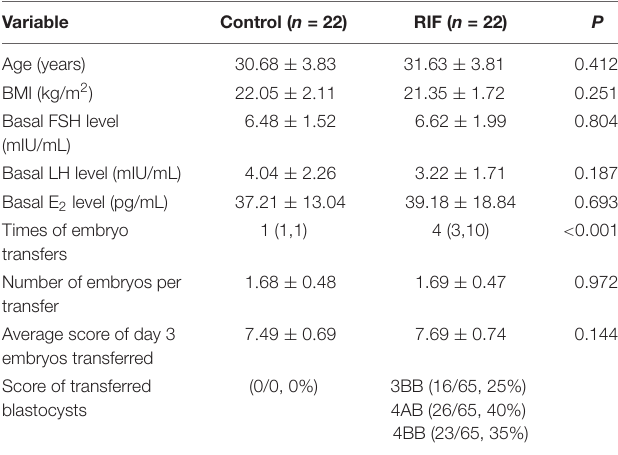
Data presented as mean ± SD or frequency. The difference between control and RIF patients was analyzed by an independent samples t-test except “times of embryo transfers,” which was calculated by independent-samples Mann–Whitney U-test (median, range). BMI, body mass index; FSH, follicle stimulating hormone; LH, luteinizing hormone; E 2 ,